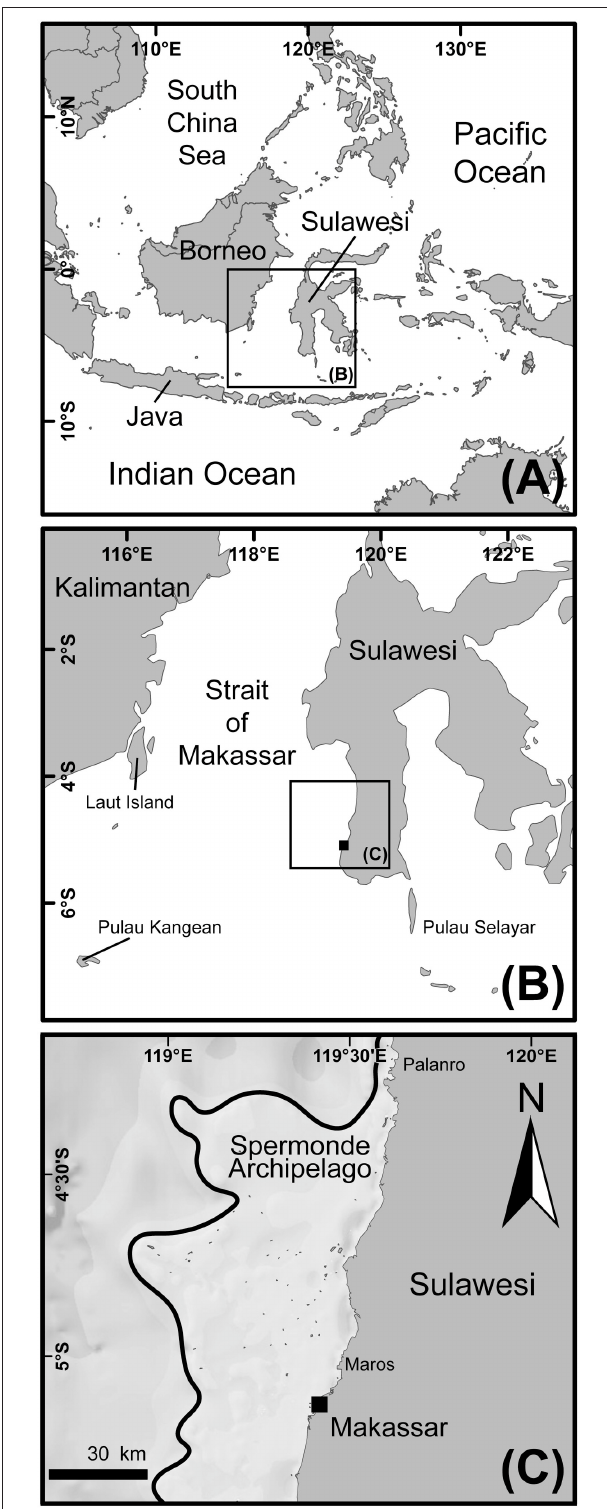
FIGURE 1 | The Indonesian archipelago and the Spermonde Shelf. (A) Location of Sulawesi in central Indonesia between the Indian and